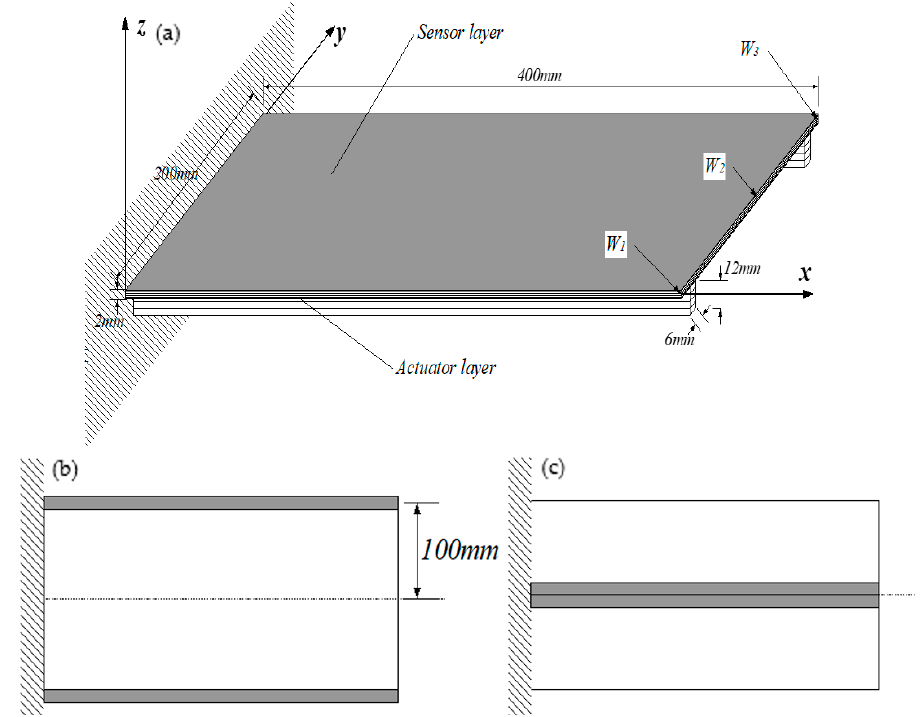
Figure 5. Cantilevered piezoelectric composite model and two cases of the stiffener’s location: ( a ) Stiffened composite model; ( b ) Stiffener Case 1; ( c ) Stiffener Case 2.